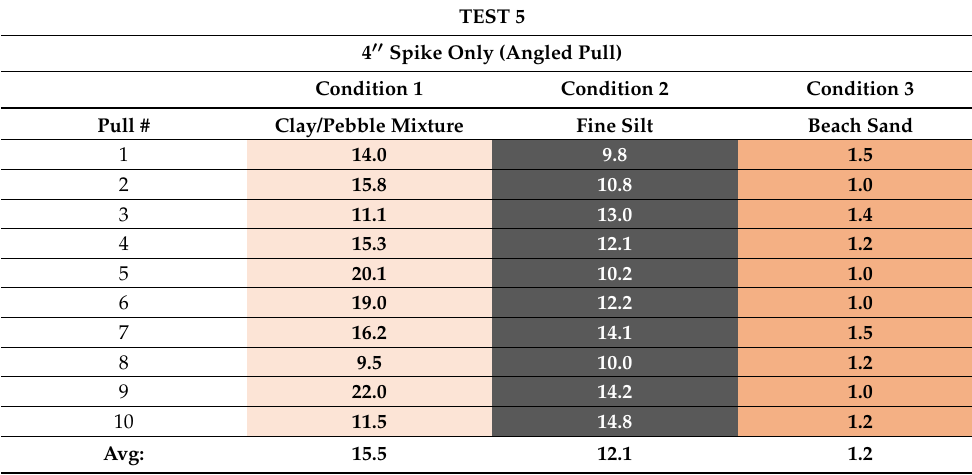
Table A5. Test 5: complete anchoring failure tension data